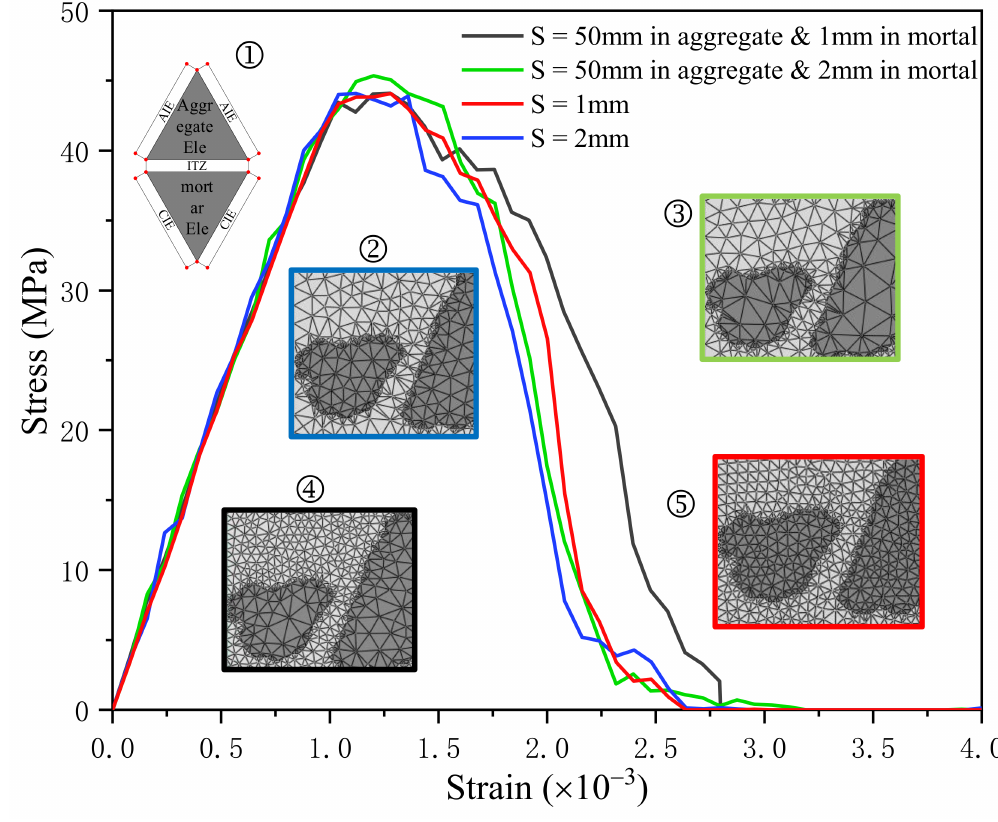
Figure 6. Stress − strain curves of different mesh forms: (cid:192) is cohesive element; (cid:193) – (cid:196) are different size of mesh